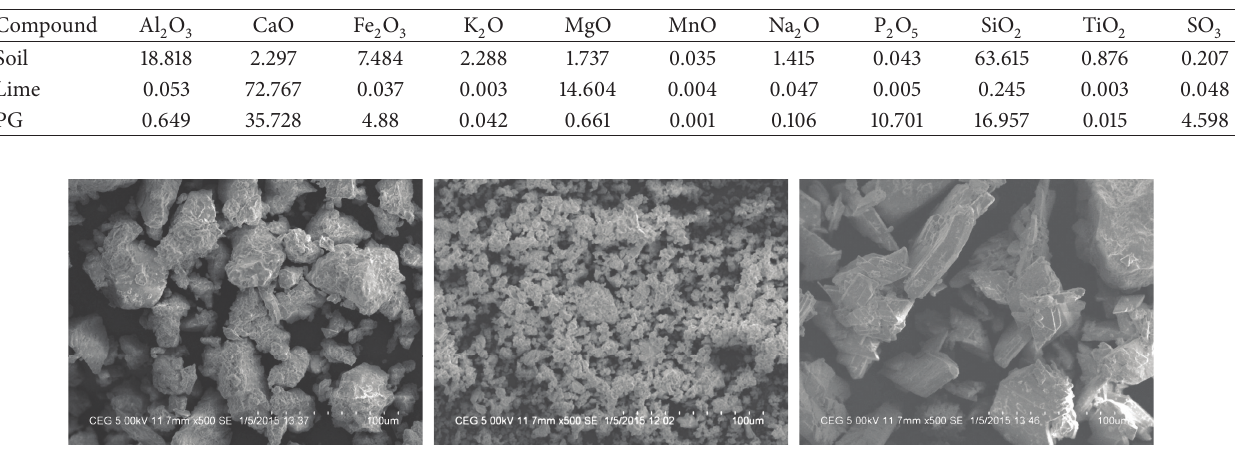
Figure 1: Microstructure of soil, lime, and